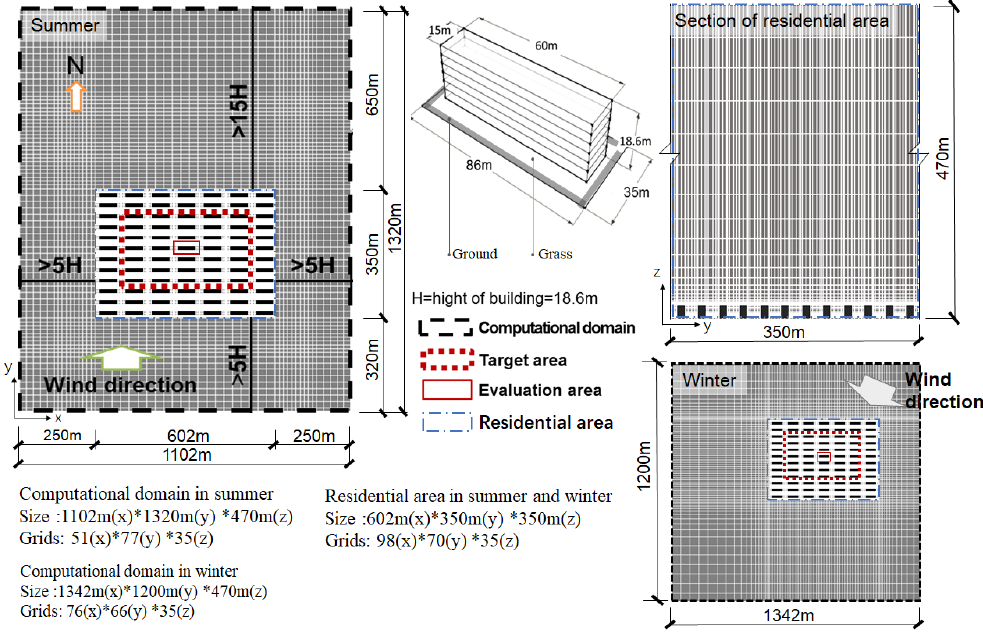
Figure 5. The analysis model used in this study.